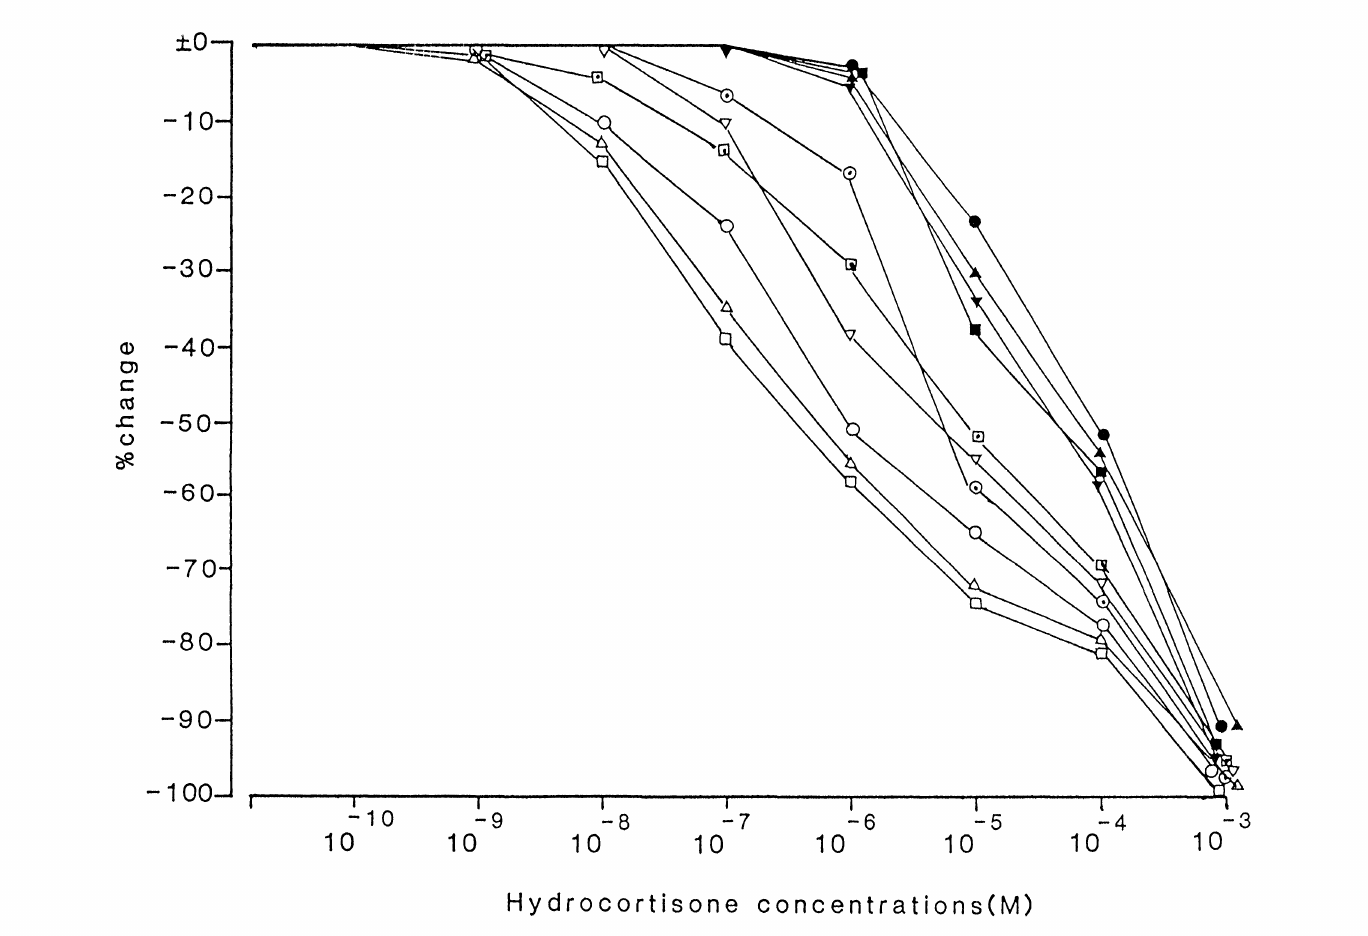
FIG. 4. Effects of varying concentrations of hydrocortisone ranging from 10 -1 M to 10 -3 M on IL-6 production stimulated by LPS (10 #g/ml) in ten normal human peripheral blood mononuclear cells. Each symbol represents an individual subject. SD of triplicate cultures was omitted to avoid further complication of the Fig. Without exception, the SD obtained at any cases was never greater than 8.7%. Results expressed as per cent decrease of the incubation without